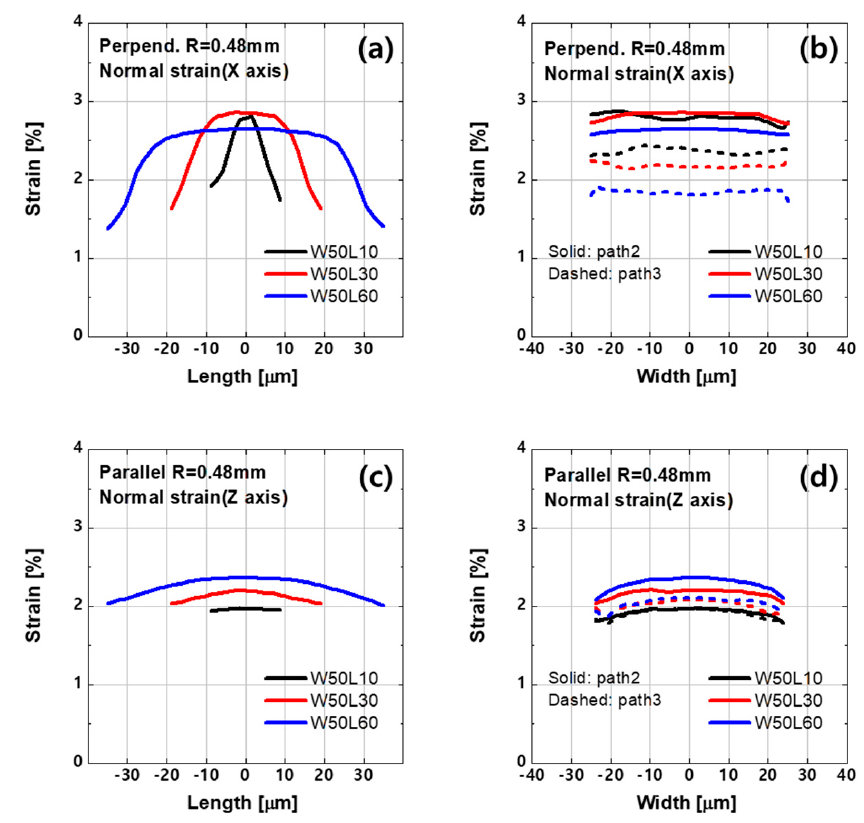
Figure 5. ( a , b ) Normal strain in the length direction ( X -axis) under perpendicular bending. ( c , d ) Figure 4c.